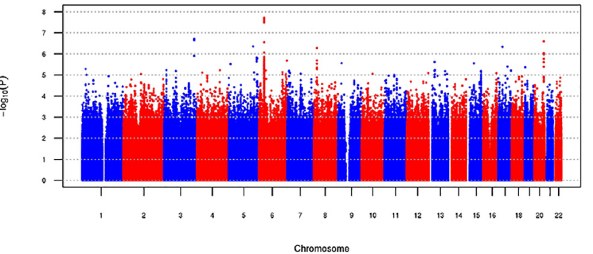
Fig 3. Manhattan plot for genome-wide association for ln(sRAGE) in blacks (N =